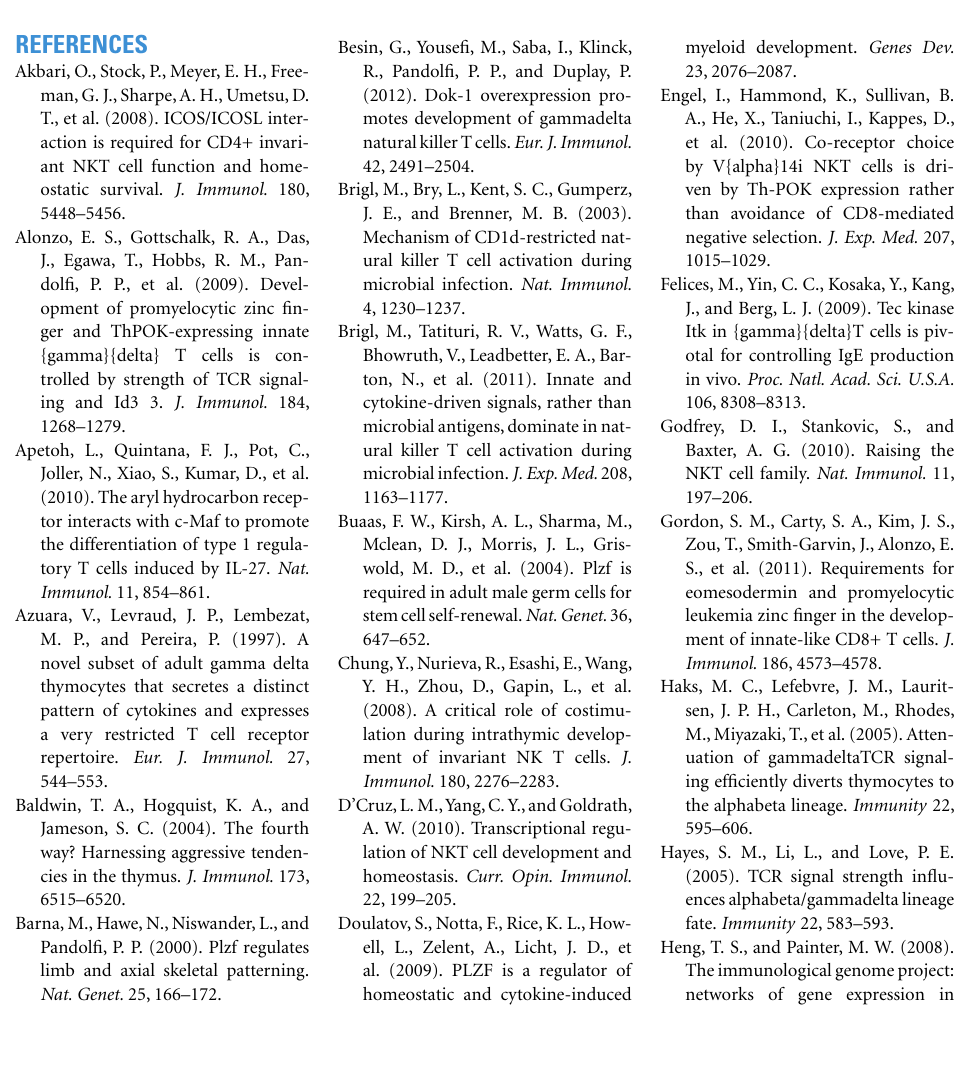
FIGURE 5 | PLZF regulates the expression of receptors for IL12 and IL18. Thymocytes from mixed chimeras with wt (CD45.1) and PLZF lu/lu (CD45.2) bm were stained with PBS-57-loaded CD1d tetramers and antibodies against the indicated surface markers. Expression of IL12Rb1 (A) and IL18R1 (B) on total iNKT cells (TCR β + CD1d-Tet + ) (left), stage 0/stage 1 iNKT cells (CD44-NK1.1-TCR β + CD1d-Tet + ) (center) and γδ NKT (TCR γδ + V δ 6.3 + ) cells (right) is shown (staining for iNKT and γδ NKT cells were performed